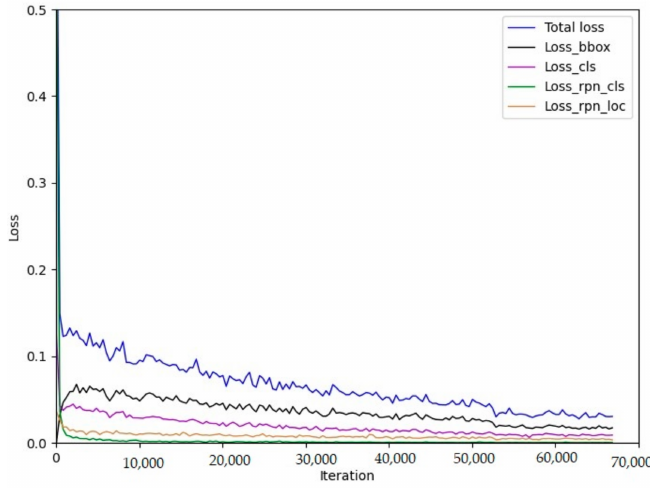
Figure 8. The loss curves.